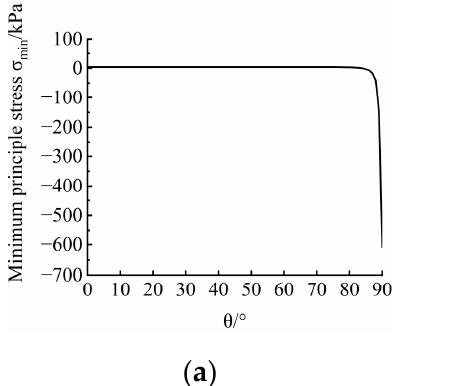
Figure 10. Phase Ⅱ ( β ≈ 60°). ( a ) Distribution of minimum principal stress; ( b ) distribution of strength.